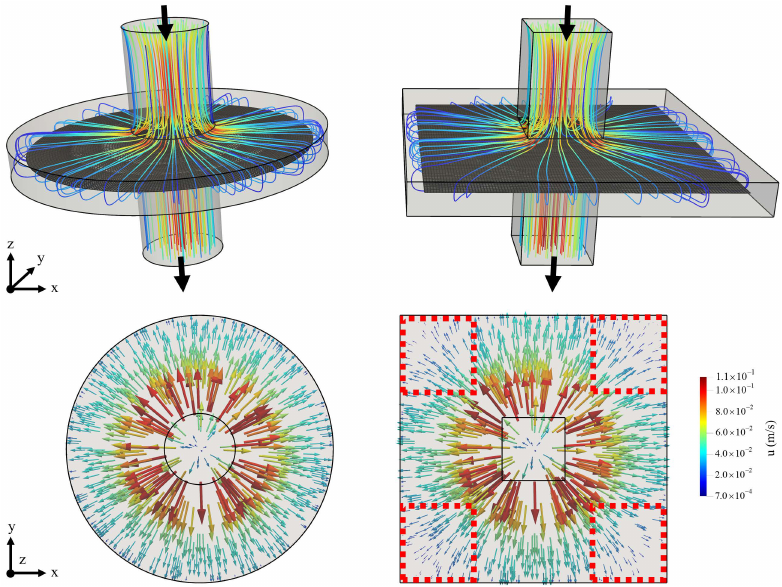
Figure 5. The distribution of flow vectors and flow pathlines in single–mixing–box circular ( left ) and square ( right ) fluid overlapping design configurations (Re = 10). Black arrows show flow